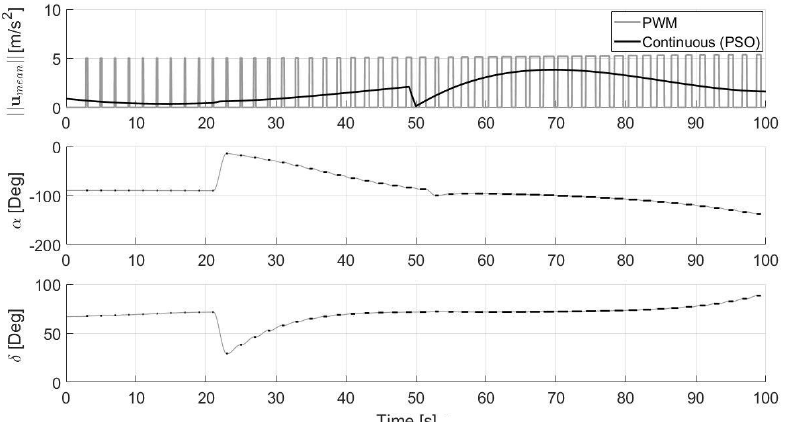
Figure 25. Time-history of commanded acceleration and direction angles for the hardware